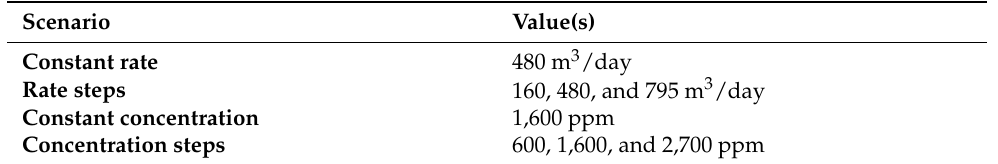
Table 2. Rates and concentrations used for stepping generic scenarios.